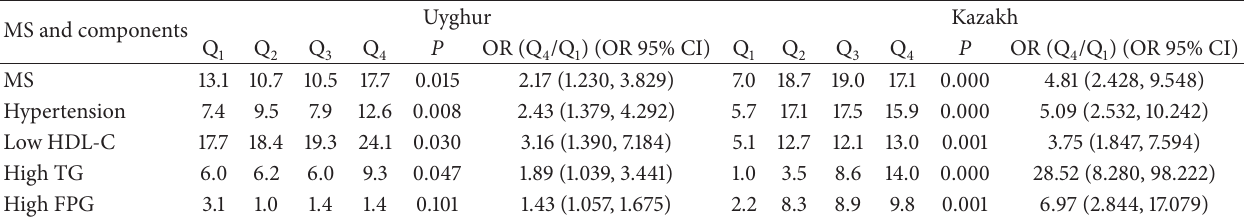
Table 4: Detection rates of MS and components in each hsCRP level quartile.